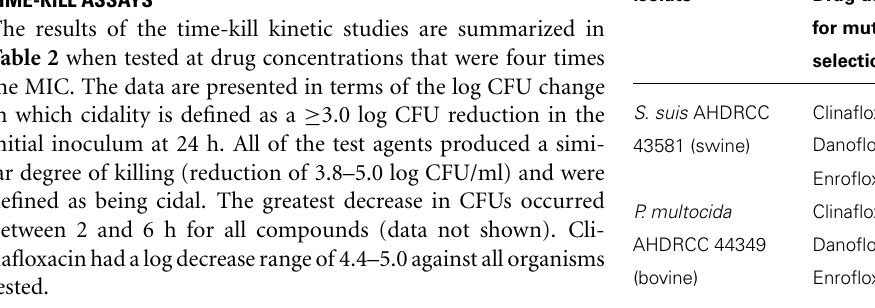
Table 3 | Mutant prevention concentration determinations of clinafloxacin and comparator drugs. Isolate Drug used for mutant